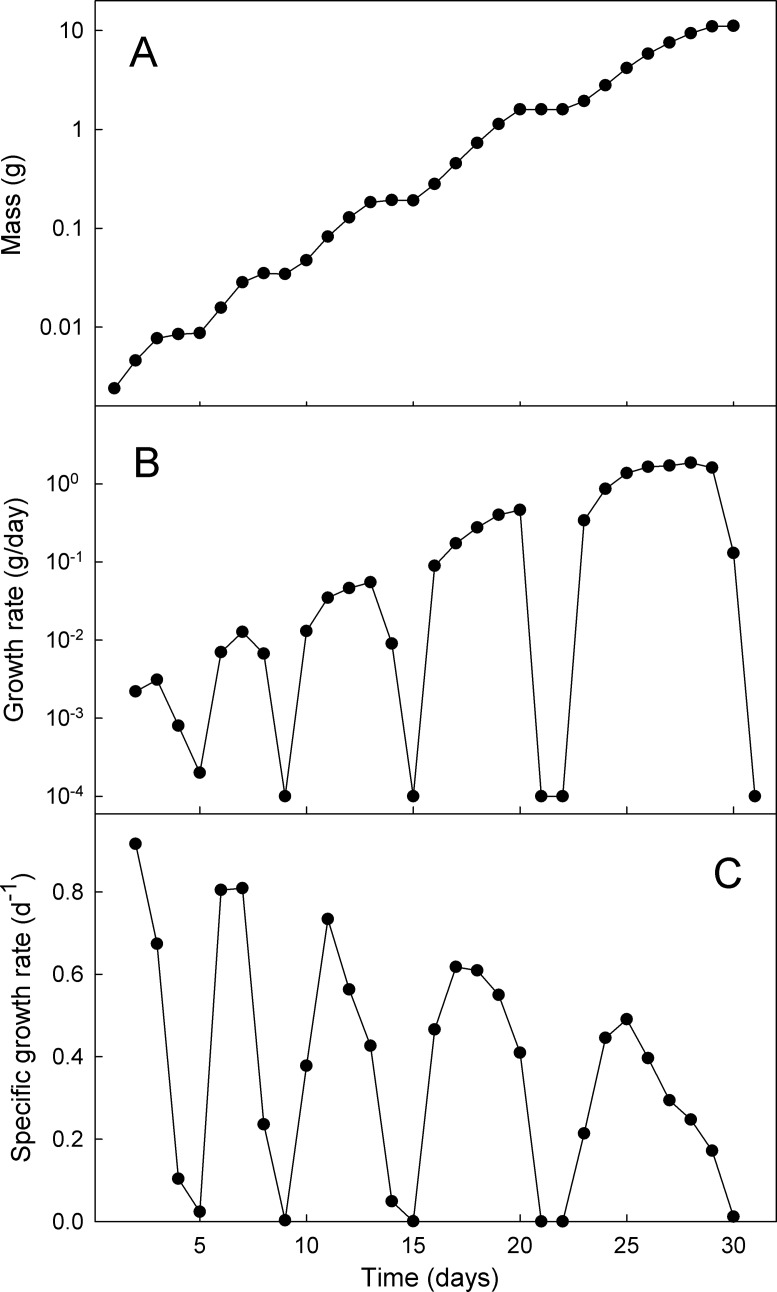
Growth rates change continually.Example of size and the rates of growth throughout larval life of an individual larva at 20°C. (A) growth, (B) growth rate, and (C) mass-specific growth rate.